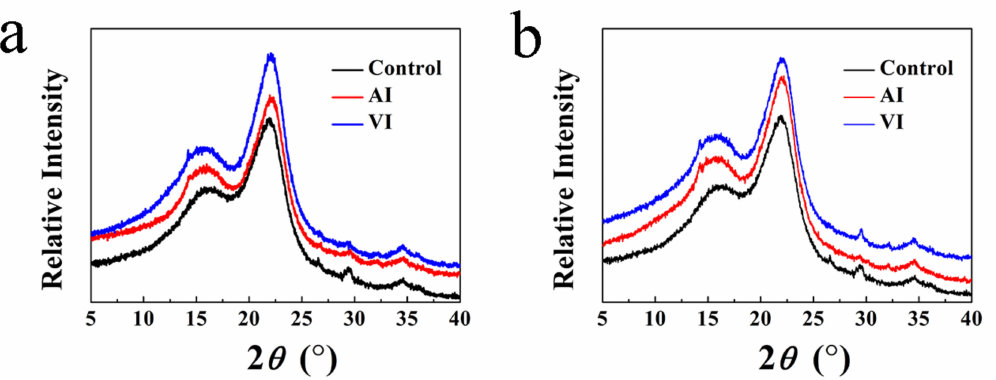
Figure 3. XRD patterns of the untreated (control) and CuAz-treated WFMRCs after 12 weeks of incubation with ( a ) T. versicolor fungi and ( b ) G. trabeum fungi. AI: atmospheric impregnation; VI: vacuum